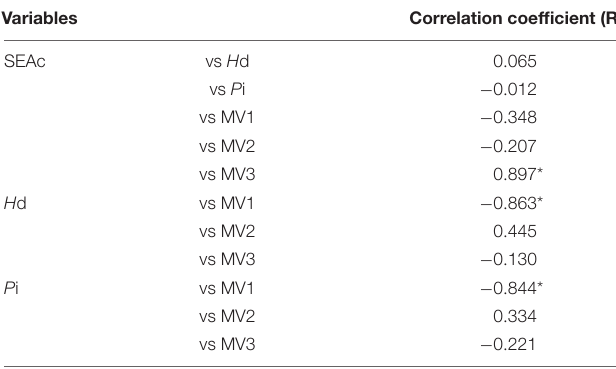
SEAc denotes the corrected standardized ellipse areas that is used to measure the trophic niche width. MV1, MV2, and MV3 are the factor scores of the first three principal components (PC1, PC2, and PC3) obtained through the principal component analysis. Hd is the haplotype diversity, Pi is the nucleotide